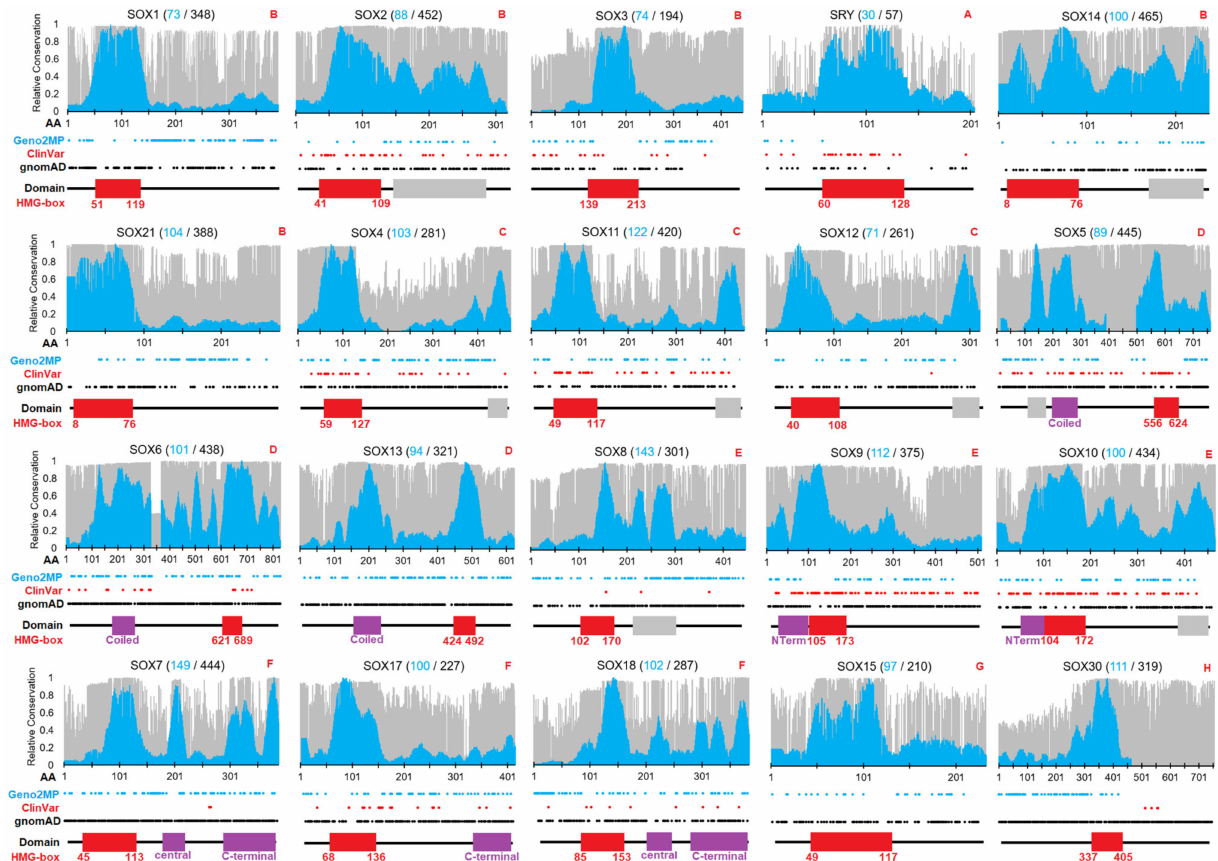
Figure 1. Conservation and variants for each of the 20 SOX genes/proteins. In total, 1890 nucleic acid sequences (cyan) and 6667 amino acid sequences (gray) were analyzed for 20 SOX genes throughout vertebrate species. The evolutionary selection was mapped for each gene using the indicated number of sequences on a scale of 0 (weak conservation) to 1 (high conservation). Shown below the conservation data are the locations of human variants from Geno2MP (cyan), ClinVar (red), and gnomAD (black). UniProt-designated domains are shown below, each with the HMG box identified in red. HMG box human numbers are shown below the domain. Red letters at top right corner indicate the SOX subfamily annotation. The raw TIF file can be found at https: //doi.org/10.6084/m9.figshare.21830343.v1 (accessed on 18 December